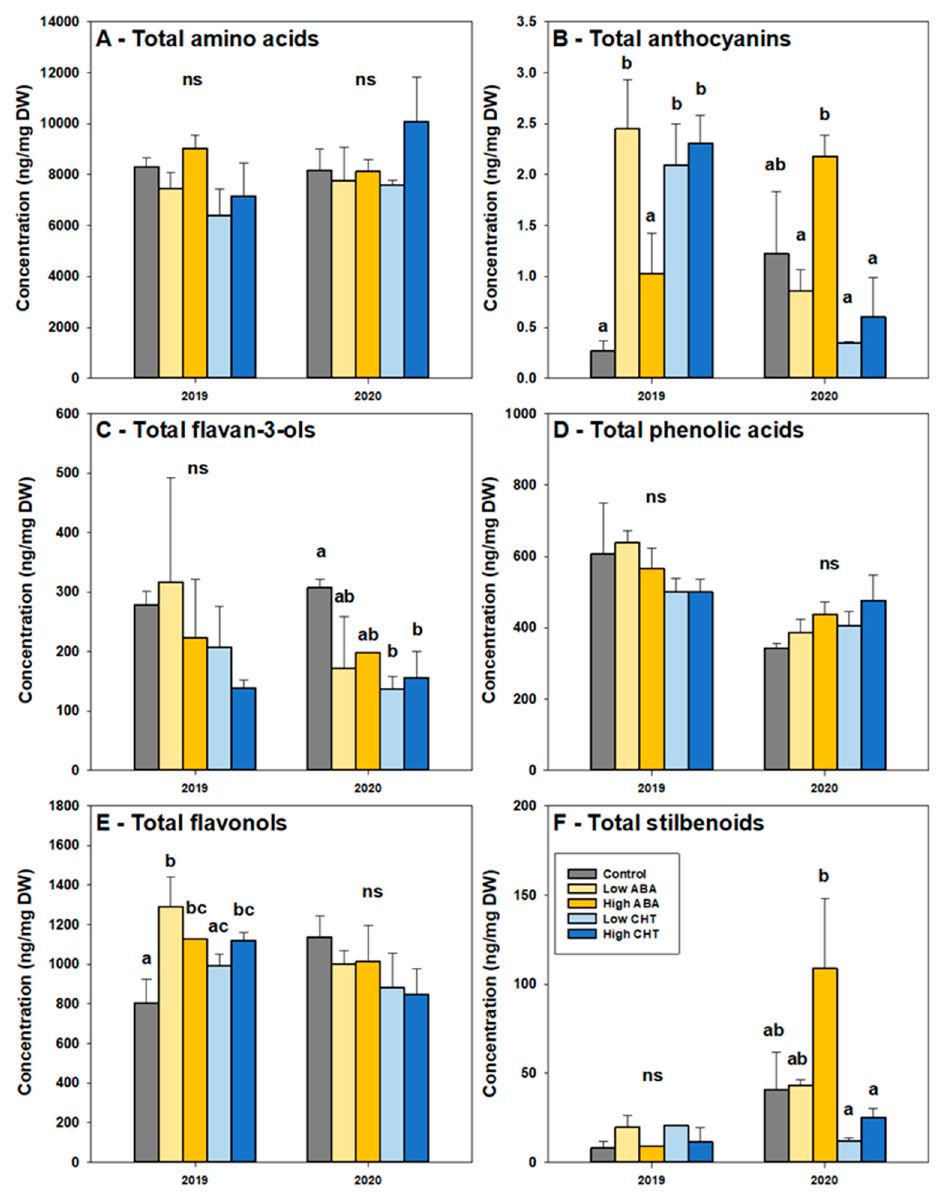
Figure 3. Total concentrations of amino acids ( A ), anthocyanins ( B ), flavan-3-ols ( C ), phenolic acids ( D ), flavonols ( E ) and stilbenoids ( F ) in Savvatiano berries at veraison stage in 2019 and 2020 treated with abscisic acid and chitosan: control (grey), low concentration of abscisic acid (light yellow), high concentration of abscisic acid (dark yellow), low concentration of chitosan (light blue) and high concentration of chitosan (dark blue). Error bars represent the standard deviations. No significant difference (ns) was found between values with the same letters (one-way ANOVA, p -value >